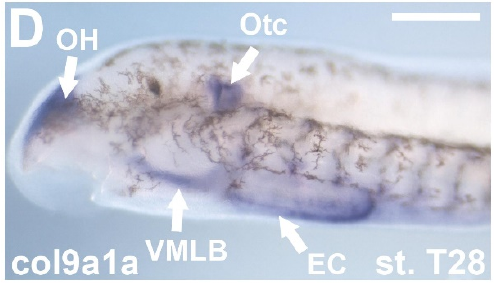
Figure 5. Molecular heterogeneity in larval lamprey cartilages during development. ( A ) Diagram of the larval lamprey skeleton at Tahara [131] stage T28–30. ( B ) Expression of lecA at stage T28. ( C )